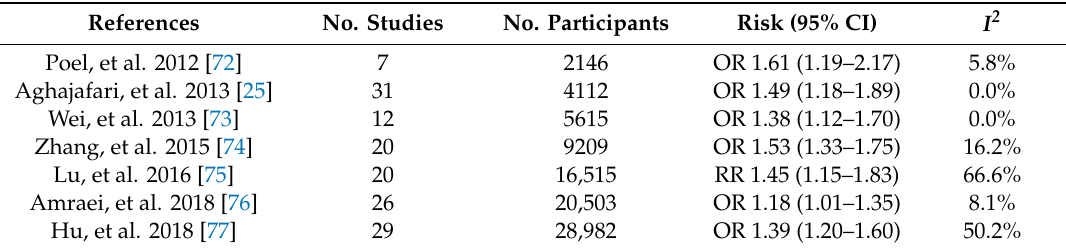
Table 1. Association between insu ffi cient vitamin D and risk of Gestational Diabetes Mellitus in selected meta-analyses of observational